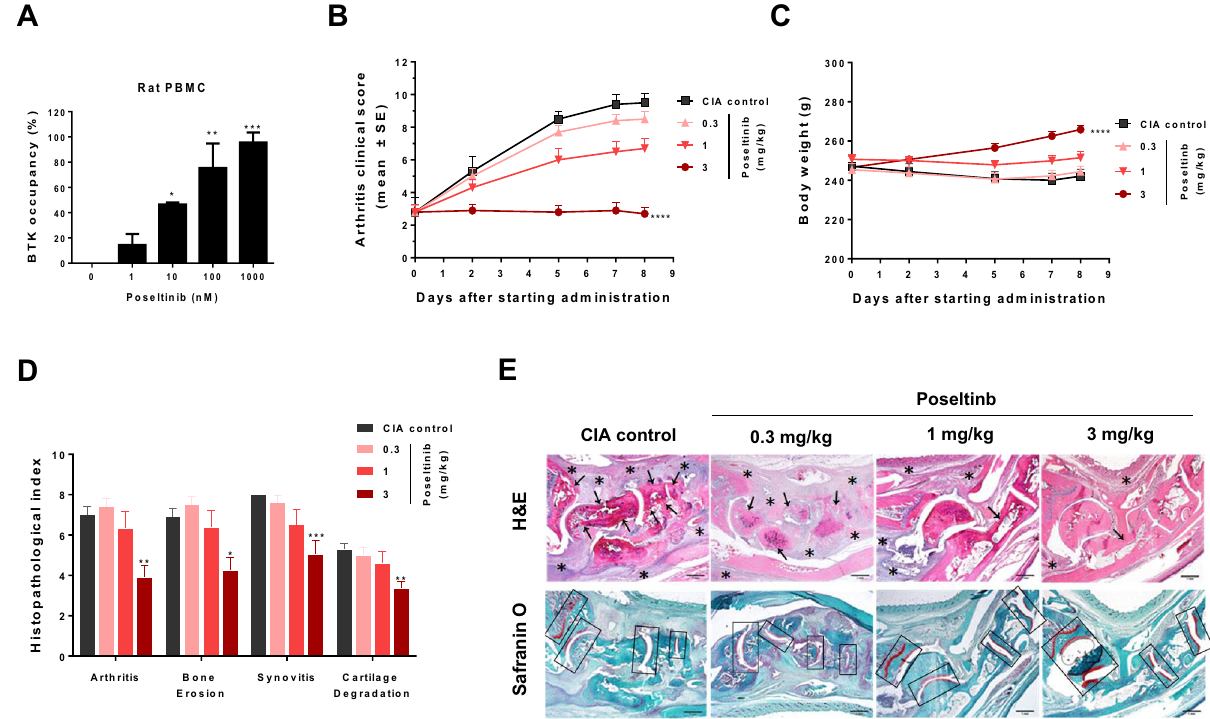
Figure 4. Dose-dependent inhibition of arthritis severity by poseltinib in a rat model of collagen-induced arthritis (CIA). ( A ) Normal rat PBMC were treated with poseltinib at the indicated concentrations for 1 h, and then free BTK was detected using a biotinylated poseltinib probe, as described in the Materials and Methods. BTK occupancy (%) was calculated from the free BTK percentage, which was compared with that of the untreated control group. The bars represent the ± S.D of independent experiments. * p < 0.5, ** p < 0.1 and *** p < 0.001 vs. the nontreated control group. ( B – E ) CIA-induced rats were administered the indicated dose of poseltinib for 9 days starting 6 days after injection of type II collagen emulsion. ( B ) The clinical scores and ( C ) body weight loss of rats treated with the drug for 9 days were estimated. ( D ) Histopathological index analysis of both hind legs was conducted on the final day to assess ankle joint damage. ( E ) Representative images of H&E and Safranin-O staining of the hind legs in CIA model rats taken under a light microscope for histopathological assessment. Bone erosion ( → ) was quantified a subchondral and bone destruction and synovitis (*) was scored degree of pannus formation, including synovial inflammation, hypertrophy, interstitial edema, and fibrosis (H&E). Cartilage damage ( □ ) was semiquantitatively scored as an intensity of Safranin-O staining (red). The data are presented as the mean ± SEM. *p < 0.5, ** p < 0.1 and *** p < 0.001, **** p < 0.0001 vs. the CIA control group (one-way ANOVA for C ; Kruskal–Wallis test for B , D